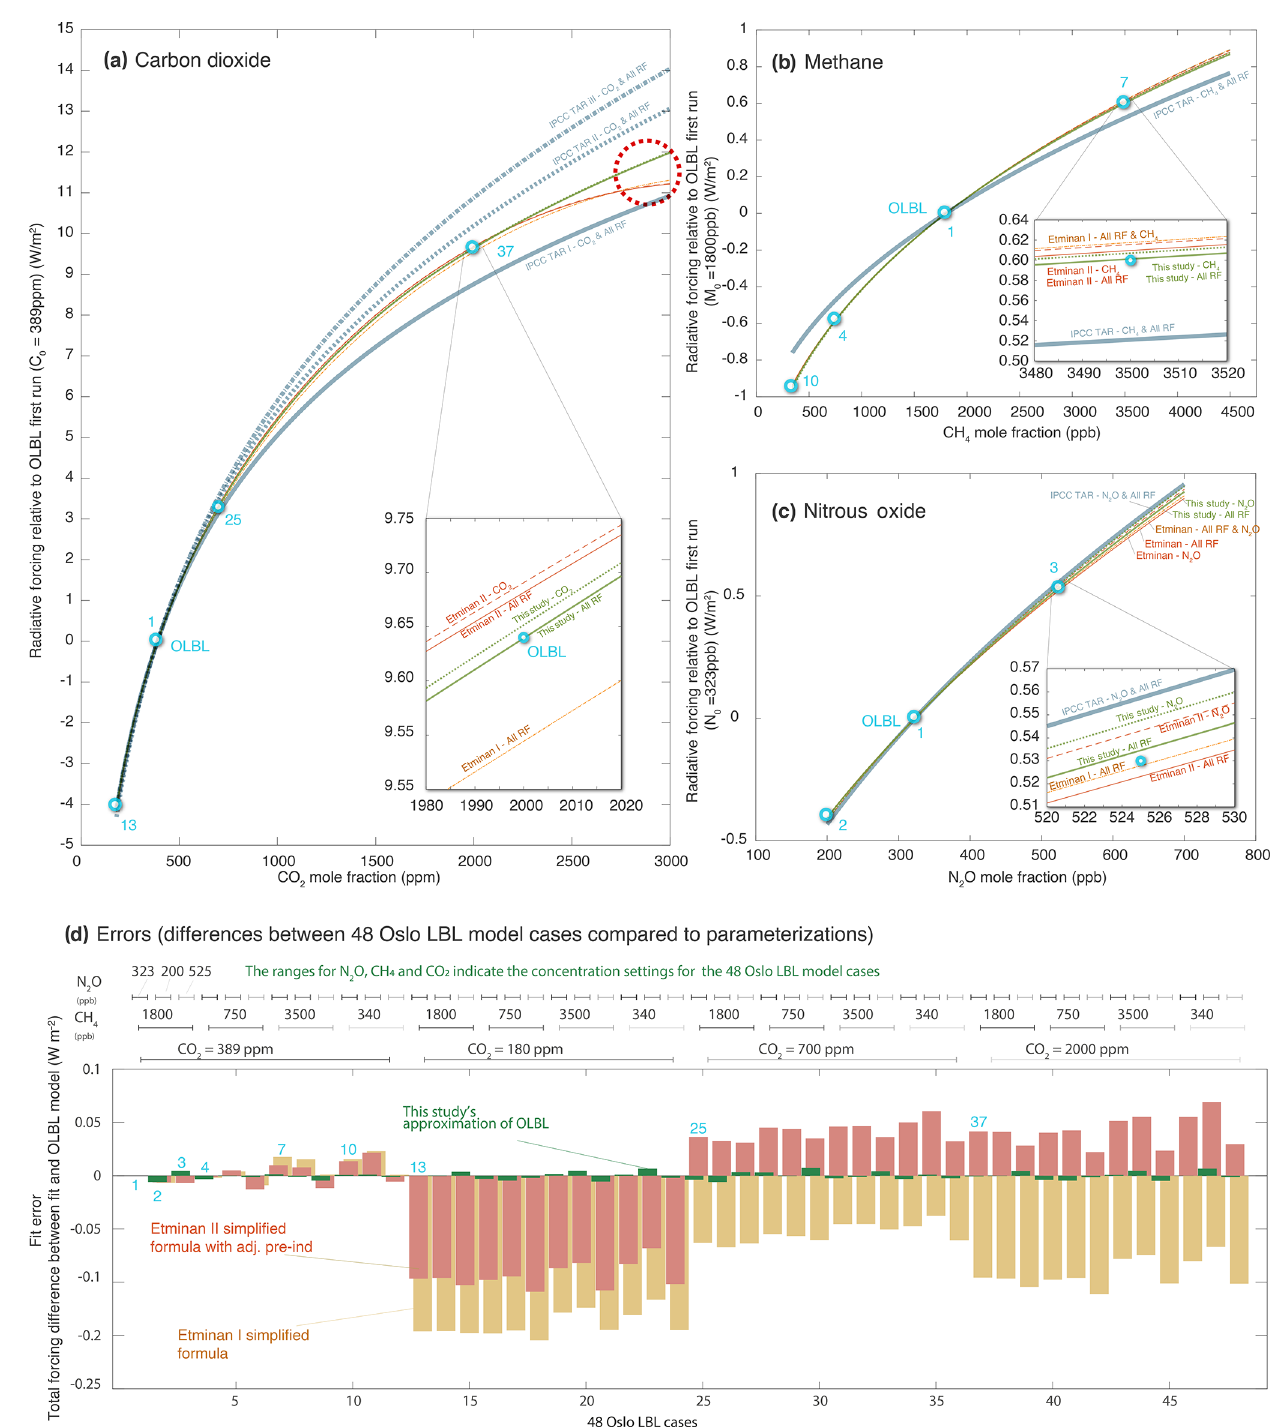
Figure 4. Simplified parameterization to emulate 48 Oslo Line-By-Line model results (bright blue open numbered circles). Shown are the IPCC TAR simplified formula for CO 2 (three options), CH 4 , and N 2 O forcing with their default parameter settings (grey-blue lines) in the background. The simplified formula results by Etminan et al. (2016) are shown as orange lines. Adjusting pre-industrial concentration values to default 1750 values improves the fit of the Etminan simplified formula (red lines in panels a to c and red error terms in panel d ). This study’s simplified formula results are shown in green, matching the Oslo Line-By-Line model results within rounding – and continuing a forcing approximation beyond 2000ppm CO 2 in line with previously derived formulas (red dashed circle in panel a ). See